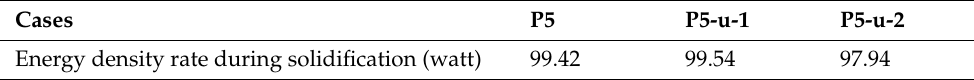
After 12 h After 16 h Figure 9. Contours of the PCM temperature distribution for three different HTF-tube arrangements of P5, p5-u-1, and p5-u-2 over multiple solidification durations. Table 5. The energy removal rate during solidification in the cases of P5, p5-u-1, and p5-u-2.